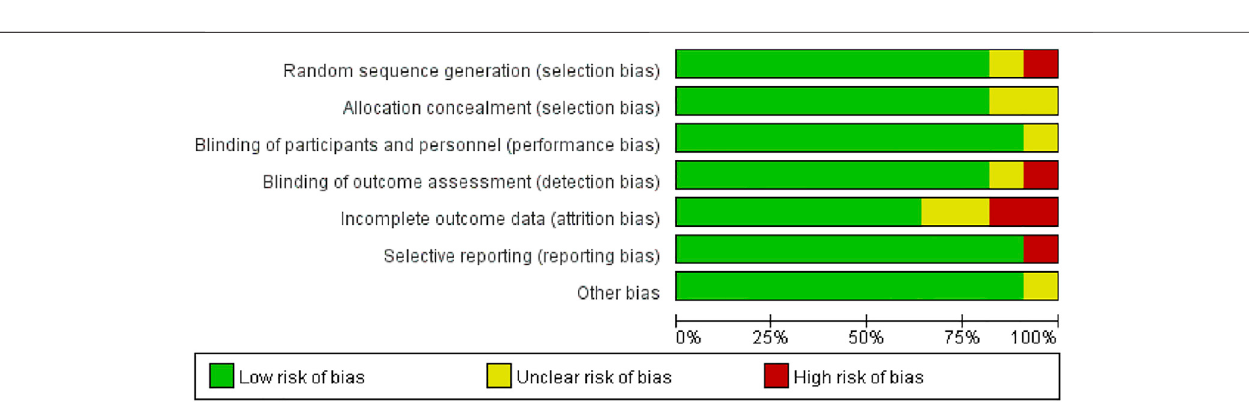
FIGURE 2 | Risk of bias assesment